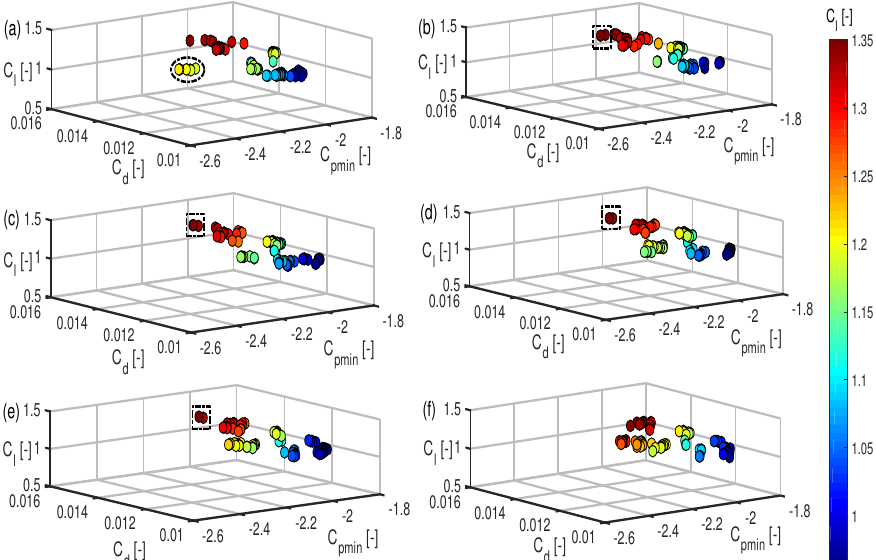
Figure 6. 3-D Pareto optimal graph of the different generations, where ( a ) represents the 5th, ( b ) represents the 10th, ( c ) represents the 15th, ( d ) represents the 20th, ( e ) represents the 25th, and ( f ) represents the 30th